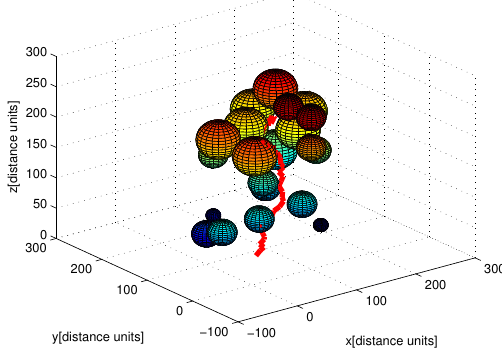
Figure 5. The path constructed utilizing one MC simulation of the 3D RRT-star planner. The obstacles are shown as spheres. The generated path is depicted with red line segments.